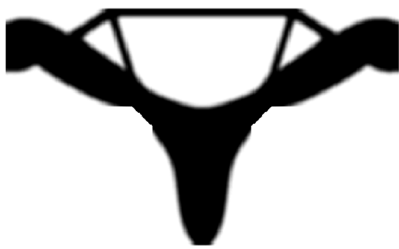
Figure 26. The final topology obtained using [35].